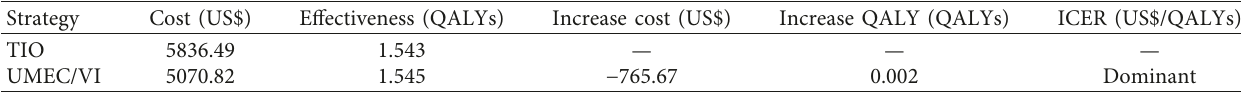
Test for overall effect: Z = 0.18 ( P = Figure 5: Forest plot of severe adverse event results for UMEC/VI vs. TIO using random-effects meta-analysis. Table 5: Costs and effectiveness of UMEC/VI versus TIO in the base case analysis over a three-year